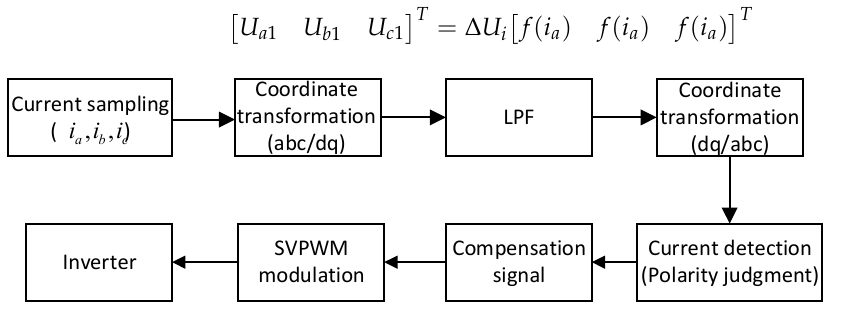
Figure 6. Dead zone compensation.